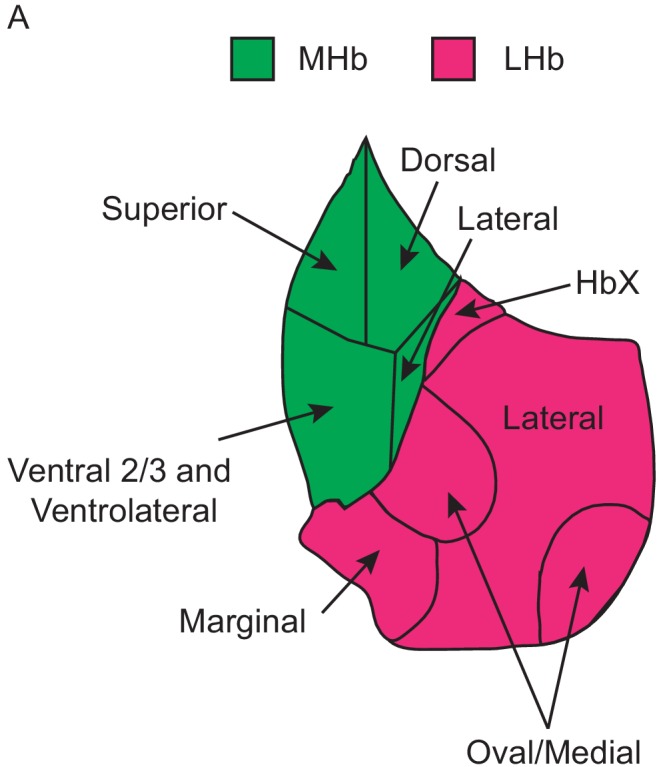
A map of habenula subregions based on single-cell transcriptomic profiling.(A) Habenular subregions are outlined in black, MHb subregions are green and LHb subregions are magenta. The location of borders is a rough estimate of a boundary between transcriptionally defined neuronal subtypes that have been confirmed with FISH and previous literature. Importantly, this map depicts the region of habenula that is located in the middle of the anterior/posterior axis of the nucleus and does not apply to the anterior and posterior poles where subregions are less well defined.